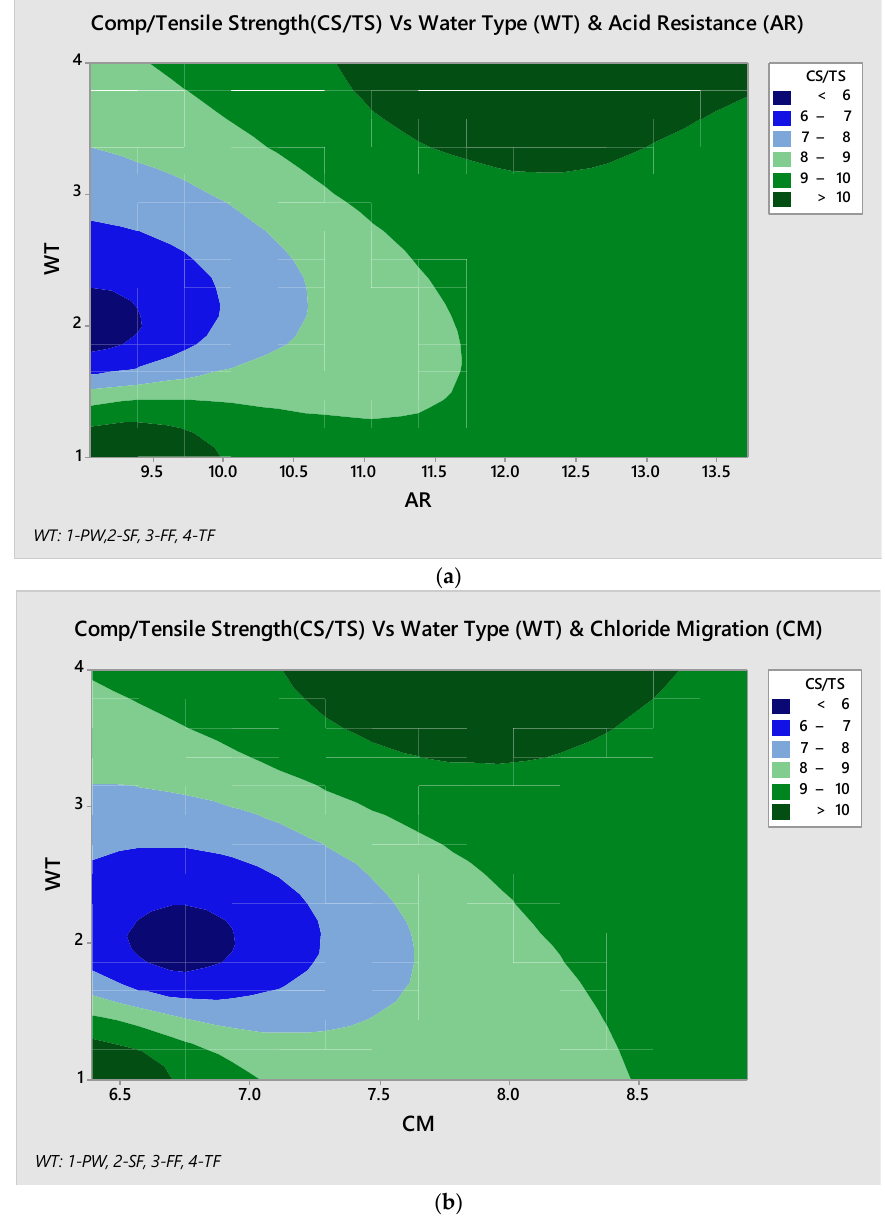
Figure 11. Relationship of CS/TS vs ( a ) acid resistance & ( b ) chloride migration at 90 days.